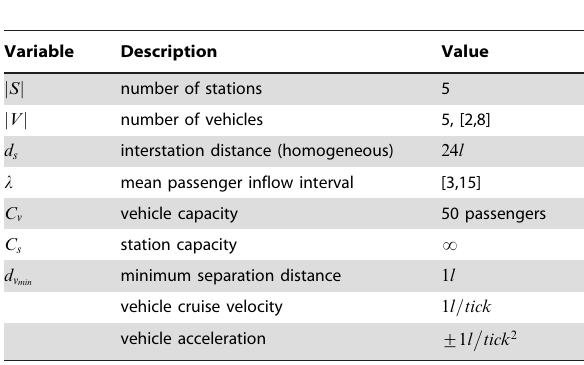
Table 1. Model parameters and values used in